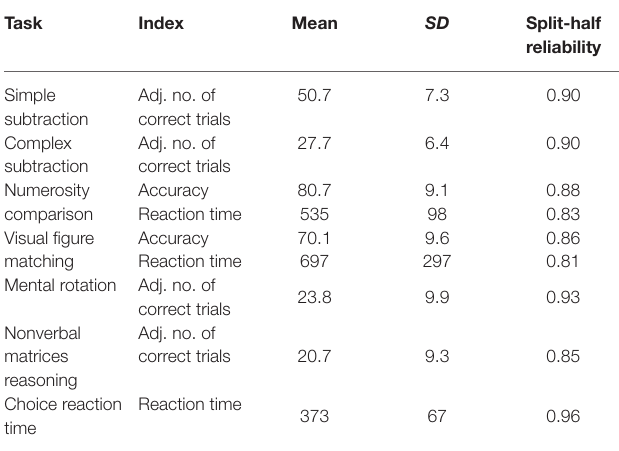
TABLE 1 | Descriptive statistics of all tasks.